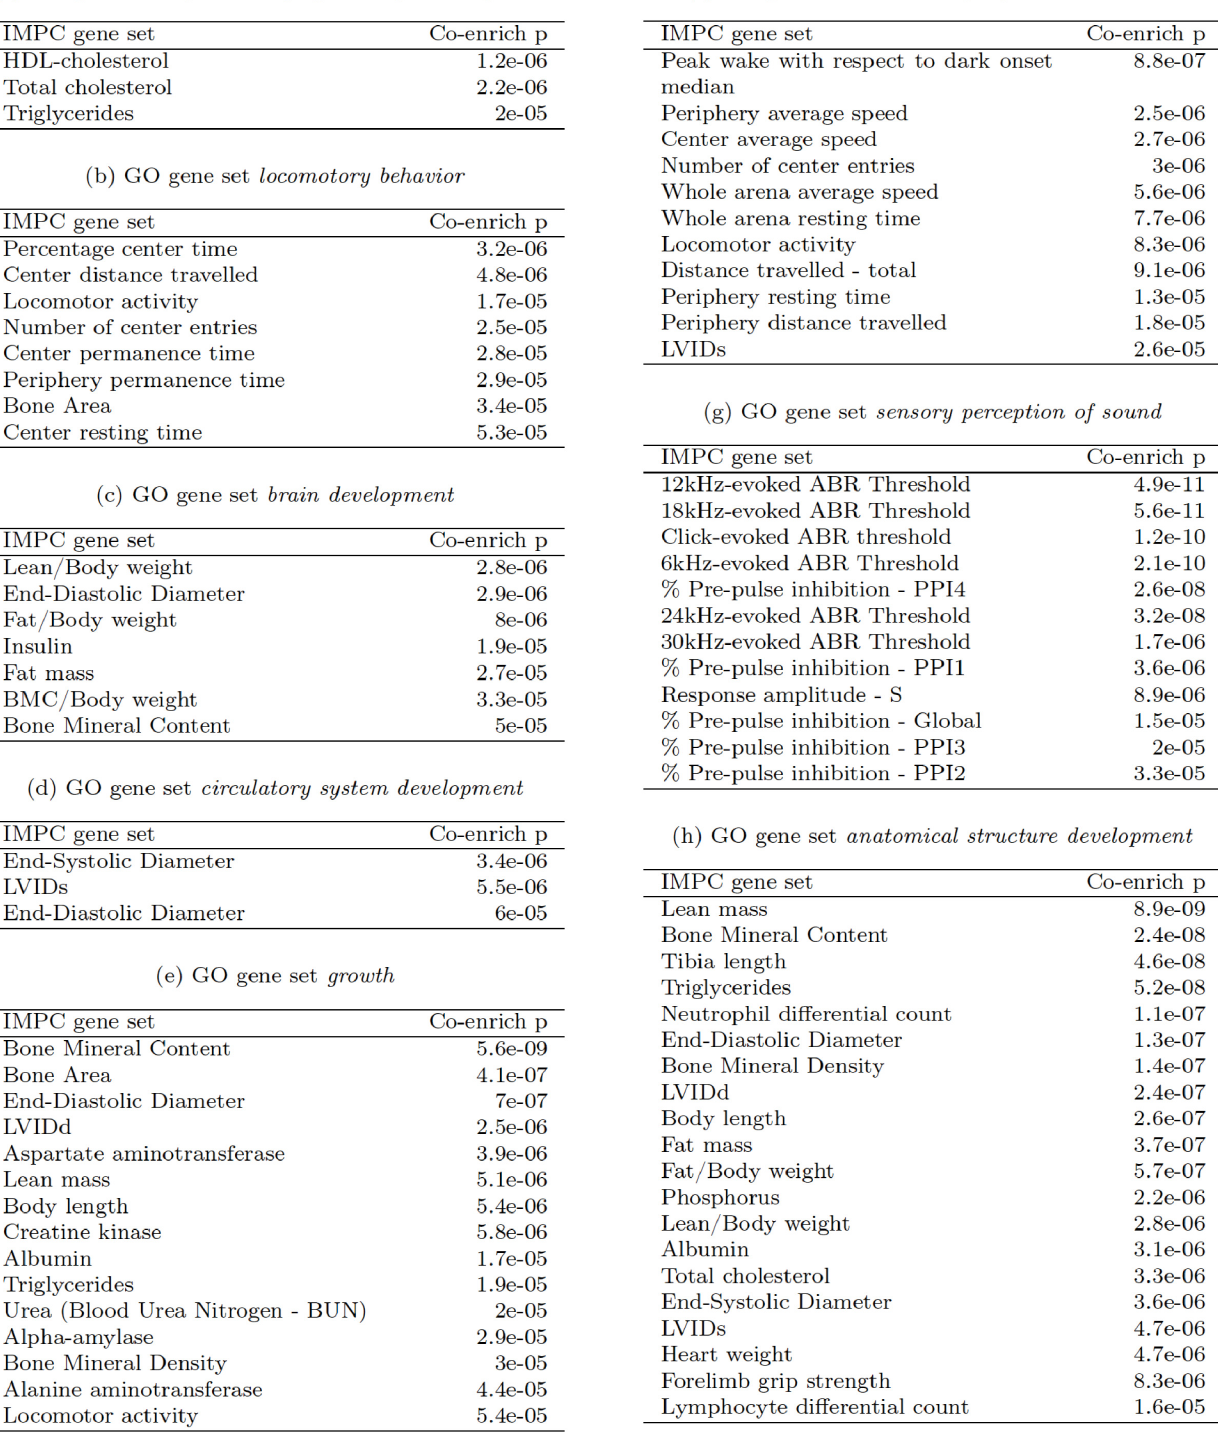
Fig 9. Examples of GO and IMPC gene set co-enrichment. Each table lists the instances of significant co-enrichment between a GO term (labelled top) and IMPC phenotypes (left column), along with Fisher exact test p -values quantifying evidence for co-enrichment (right column). GO, Gene Ontology; IMPC, International Mouse Phenotyping